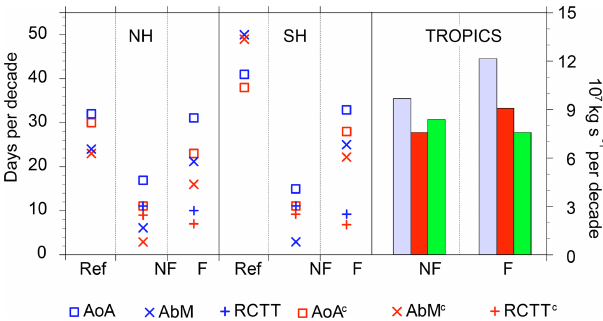
Figure 5. Trends of AoA (squares), AbM (crosses) and RCTTs (pluses) averaged over the Ex regions (ExNH on the left, ExSH in the middle) in the Ref, NF and F period in days per decade. Blue markers denote the trends in the geopotential height vertical coor- dinates and red markers the trends computed after the correction for the vertical shift of pressure levels. On the right (tropics), bars represent UP wstar trends at 20gpkm before (blue) and after the cor- rection (red) for the vertical shift of pressure levels and also after the correction for the tropopause shift (green) given in 10 7 kgs − 1 per decade. The Ref period is not included as there are no significant UP wstar trends. Presented are only trend values significant at least at the 90% confidence level. AbM and RCTT trends are computed in a reduced Ref period